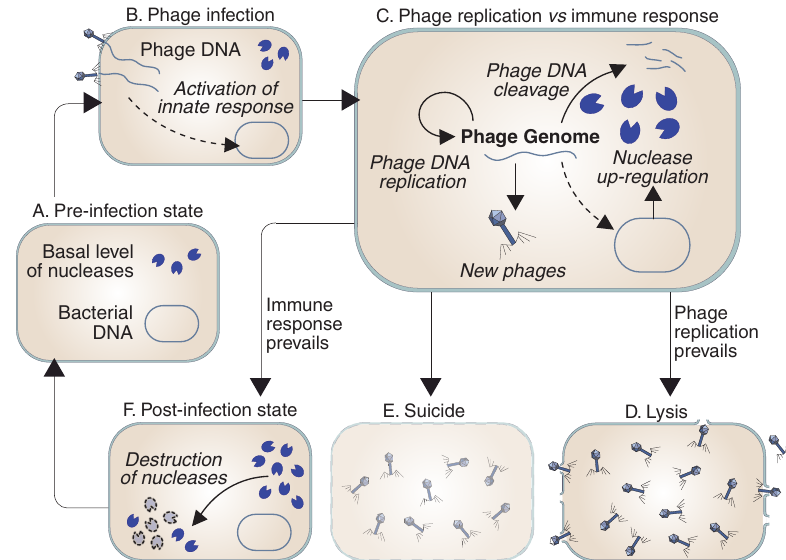
the host ’ s immune response, the bacterial cell dies and releases the newly formed phages to the extracellular space. E Alternatively, the infected cell may undergo suicide to prevent the spread of the infection. F If the host cell survives, it must deactivate its anti-phage defenses and return to the pre-infection state, which involves the downregulation of the nucleases produced during the infection and also the clearance of the remnants of viral DNA from the